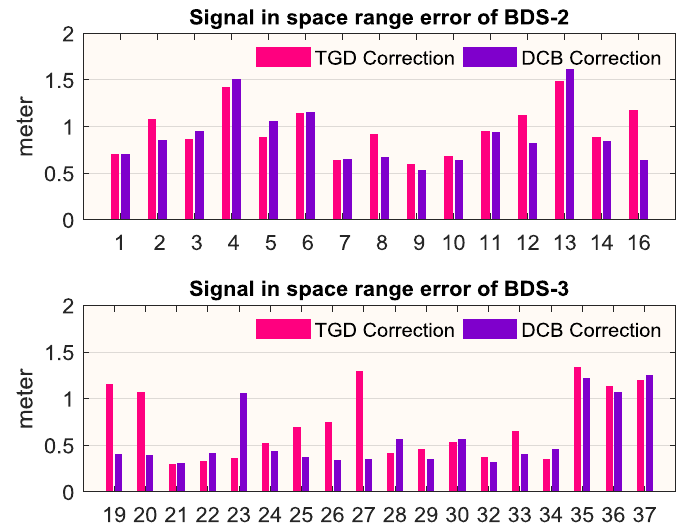
Figure 4. SISRE of BDS-2 ( upper ) and BDS-3 ( lower ) satellites on B1I / B3I ionosphere-free combination frequency, satellite clock di ff erence is corrected by TGD or DCB. Table 2. Average SISRE of BDS-2 and BDS-3 from DOY 010 to 070 in 2019 (in m).